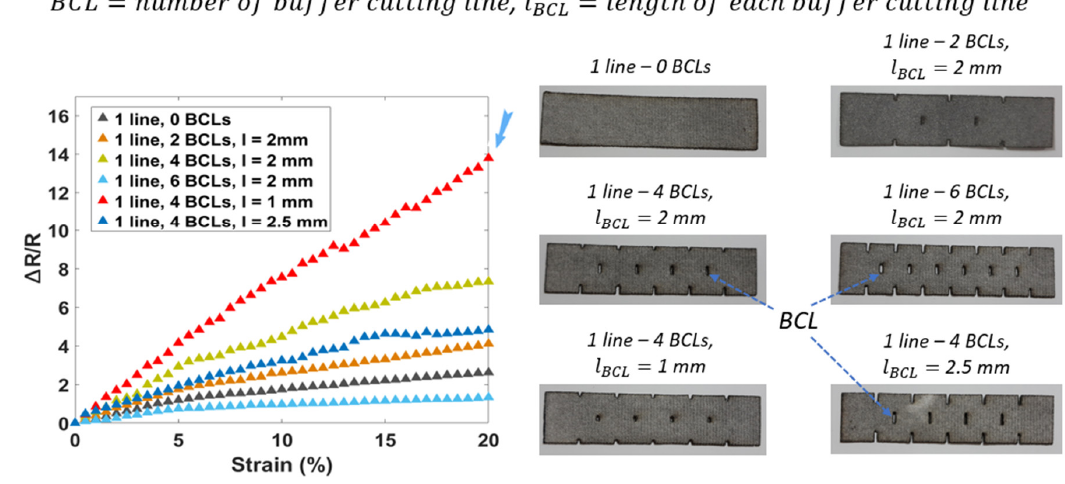
Figure 6. The third round in optimizing sensor performances based on the di ff erent lengths of the BCLs. Table 1. The GF of Ag / SWCNT samples at the strain of 20%. Sample GF